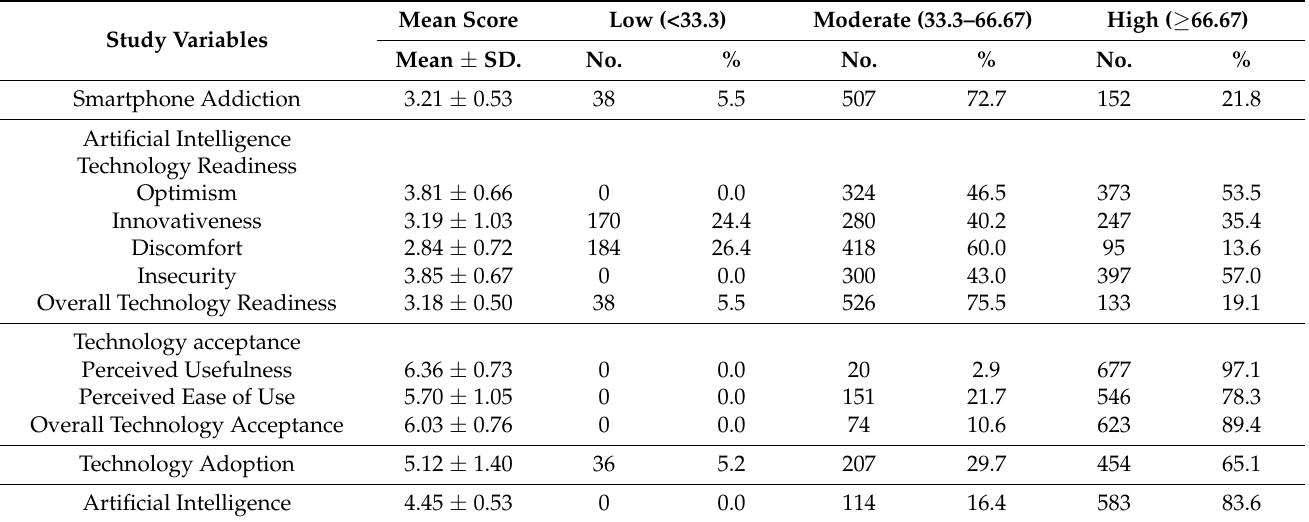
Table 2. Mean and standard deviation of the study variables ( n =